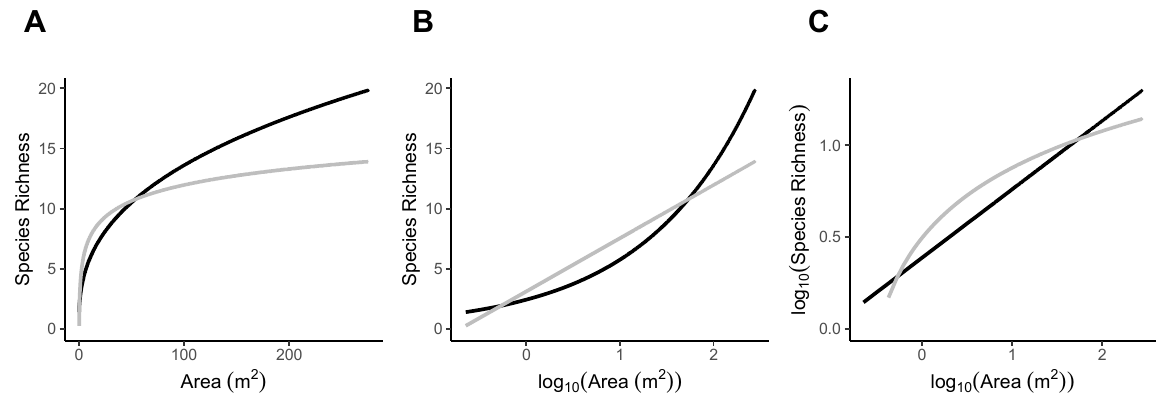
Figure 1. Graphical representation of typical power (black) and exponential (grey) species-area relationships. A, untransformed scales; B, semilog space - log-transformed area, and untransformed richness; C, log-log space - log- transformed species richness and log-transformed area. Curve functions are derived from the linear models in Table